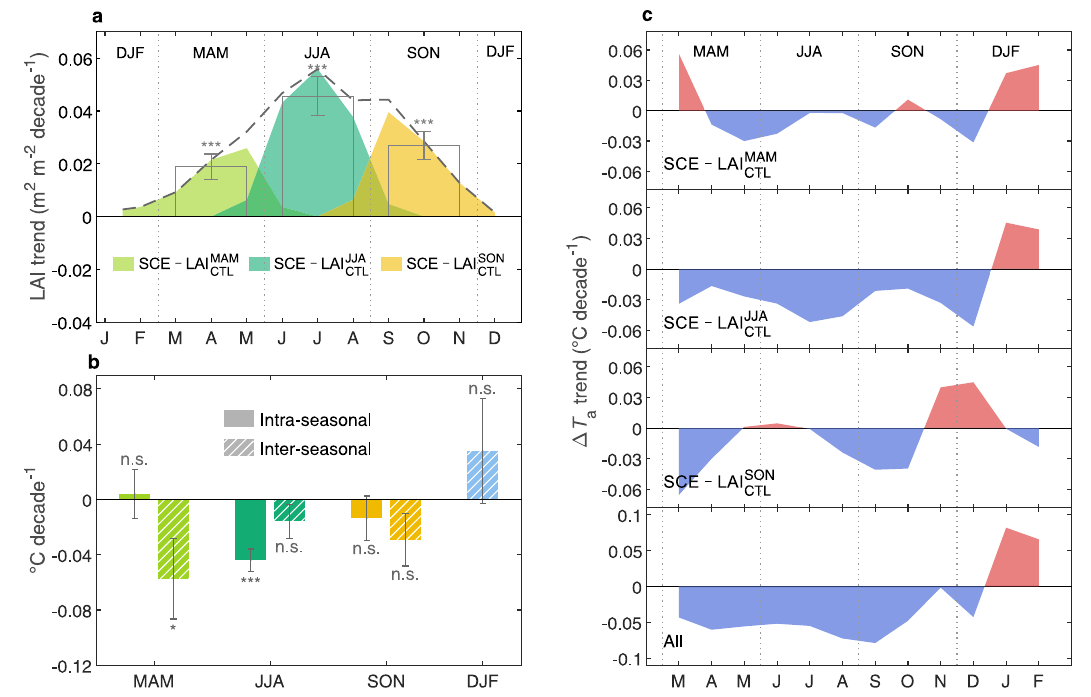
Fig. 1 Intra- and inter-seasonal temperature responses to leaf area index (LAI) changes. a Monthly trends (shadings) of Northern Hemisphere (NH) mean LAI during 1982 – 2014 used as input to the seasonal simulations. The dashed curve and transparent bars indicate trends of monthly LAI and seasonally aggregated LAI values, respectively. b Linear trends of T a driven by LAI changes within the same season (intra-seasonal) and other growing seasons (inter-seasonal). Error bars in a , b indicate uncertainty ranges [1 – standard deviation (SD)]. c Monthly trends of LAI-induced air temperature changes ( Δ T a ), with red and blue shadings representing positive and negative trends, respectively. The bottom panel shows the overall Δ T a trends induced by LAI changes in all growing seasons, calculated as the sum of Δ T a trends from the three seasonal runs shown separately in the above panels. *** p < 0.01; ** p < 0.05; * p < 0.1; n.s., p > 0.1. MAM March-April-May, JJA June-July-August, SON September-October-November, DJF